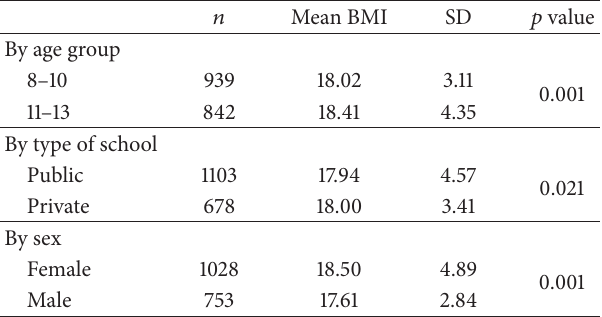
Table 2: Descriptive data and 𝑡 -tests of the mean BMI by age, type of school, and sex among primary school children aged in Dar es Salaam ( 𝑁 = 1781